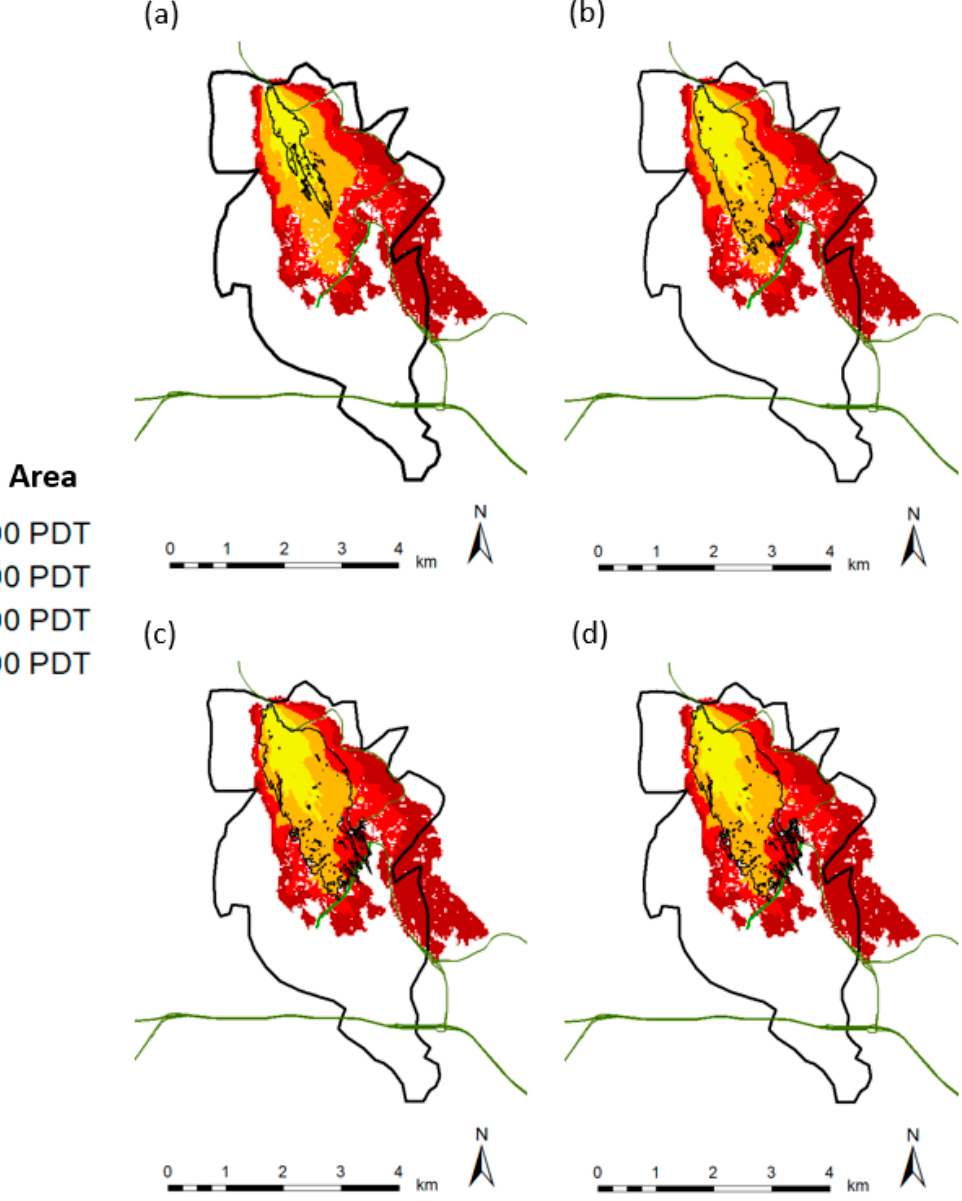
Figure 10. Same as Figure 7 with the FlamMap and FARSITE burn areas (thin, black polygons) at ( a ) 1900, ( b ), 2000, ( c ) 2100, and ( d ) 2200 PDT.